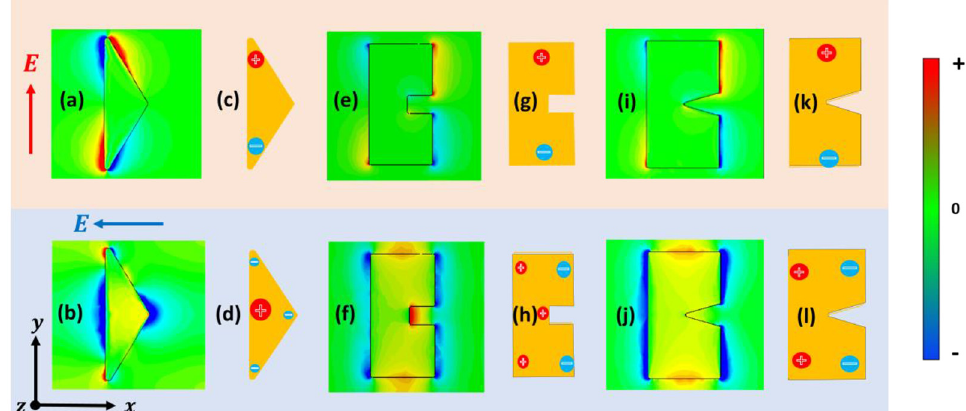
Fig. 5. E x distrubutions in unit cells of Triangle (a,b), SRR (e,f) and Heptagon (i,j) structures at fundamental and SHG resonance, respectively. Corresponding schematic charge distribution in unit cell of Triangle (c,d), SRR (g,h) and Heptagon (k.l) structures. See Supplementary Material for dynamic version of (a) and (b) and corresponding E